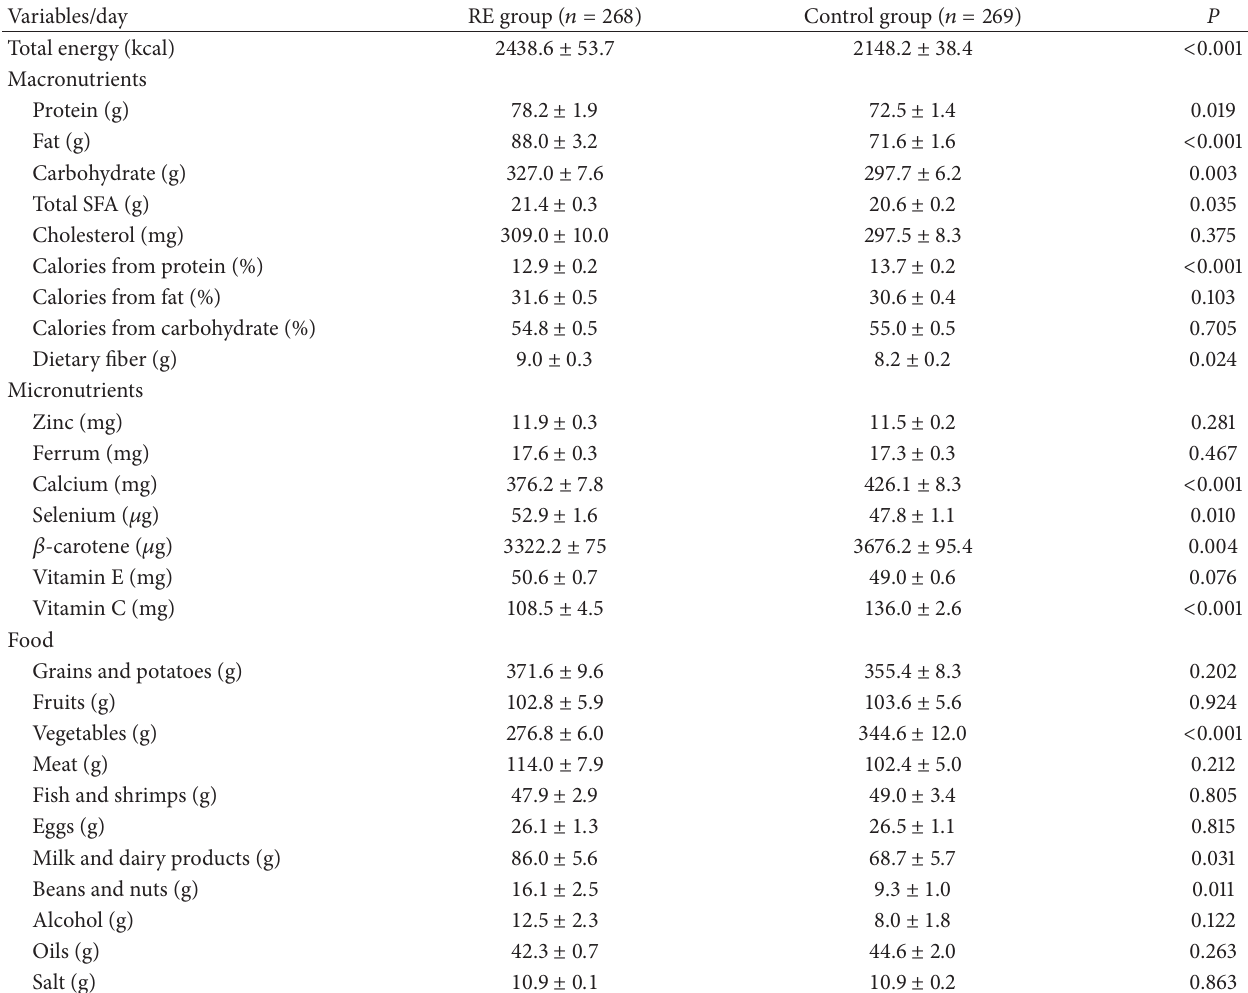
Table 3: Mean daily intake of nutrients and food in two